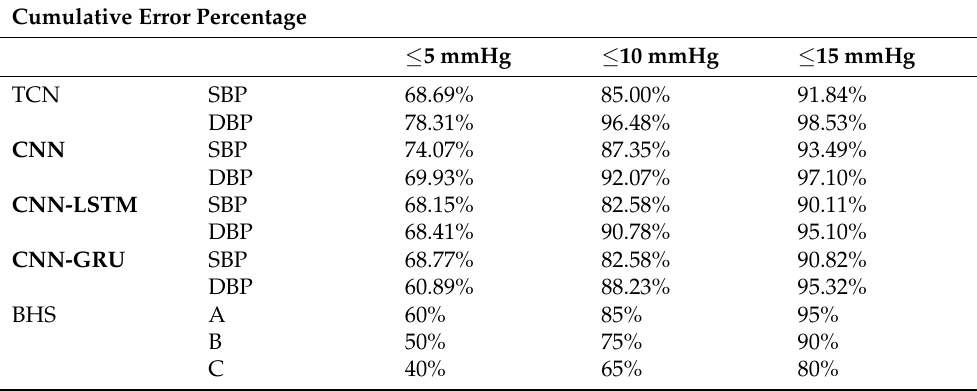
Table 4. Model performance evaluation based on BHS